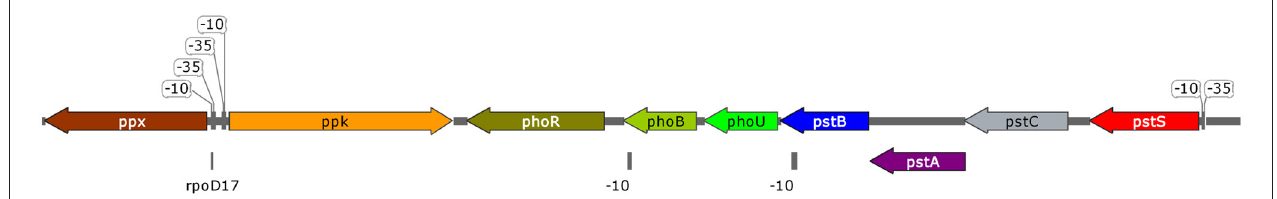
FIGURE 7 | Scheme of B. sacchari LFM101 high-affinity phosphate consumption and polyphosphate production gene